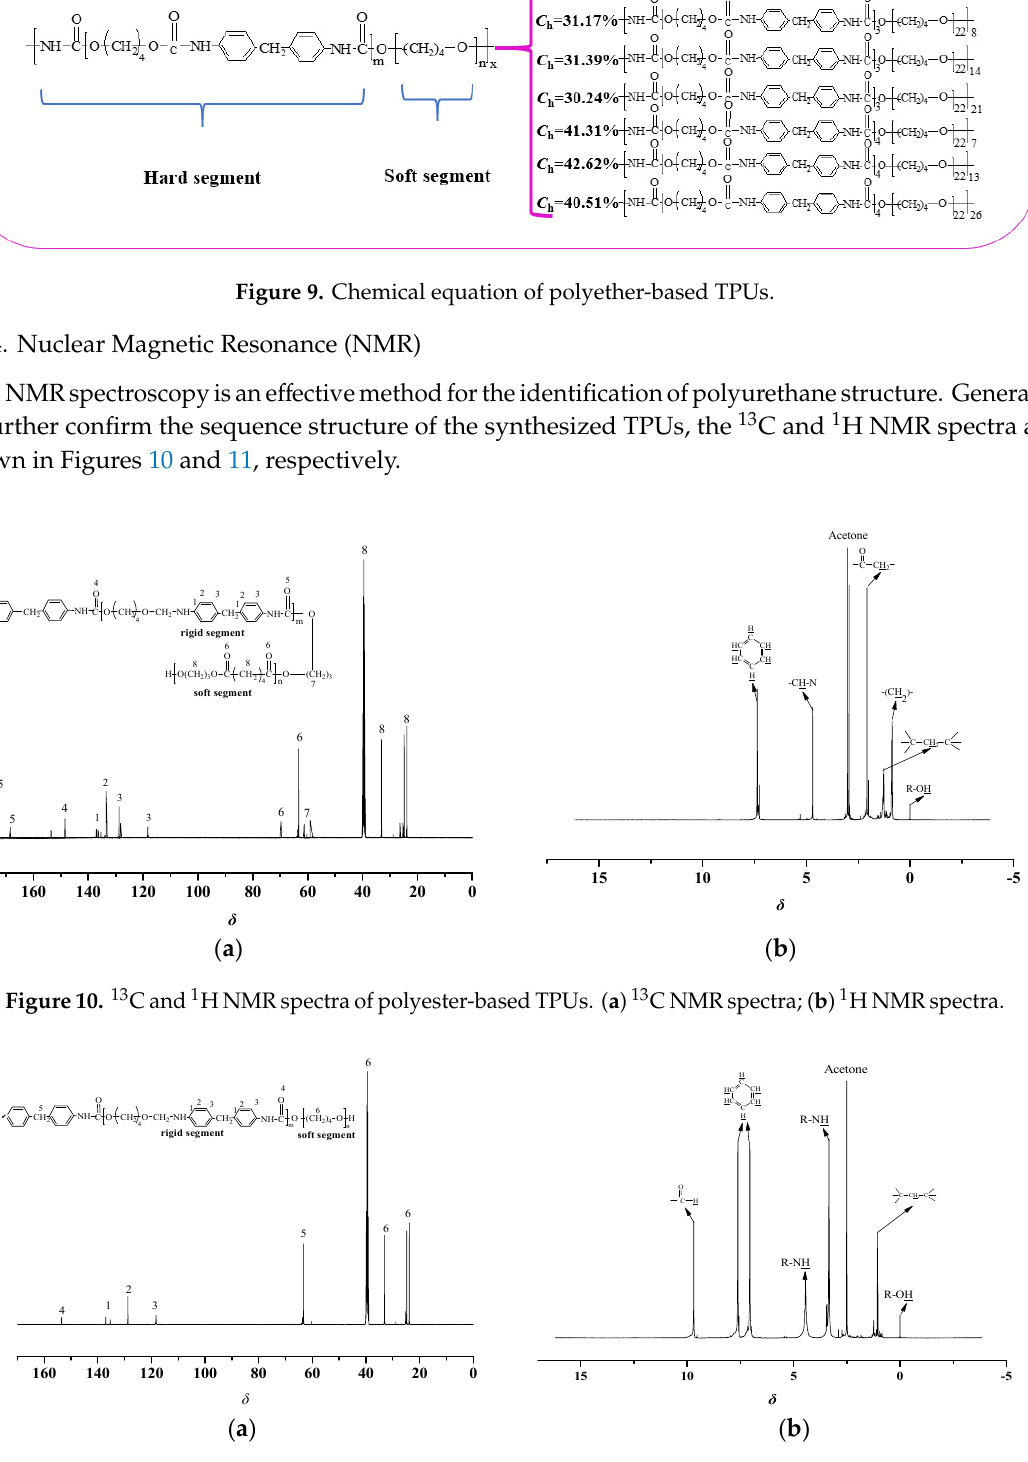
Figure 11. 13 C and 1 H NMR spectra of polyether-based TPUs. ( a ) 13 C NMR spectra; ( b ) 1 H NMR spectra.